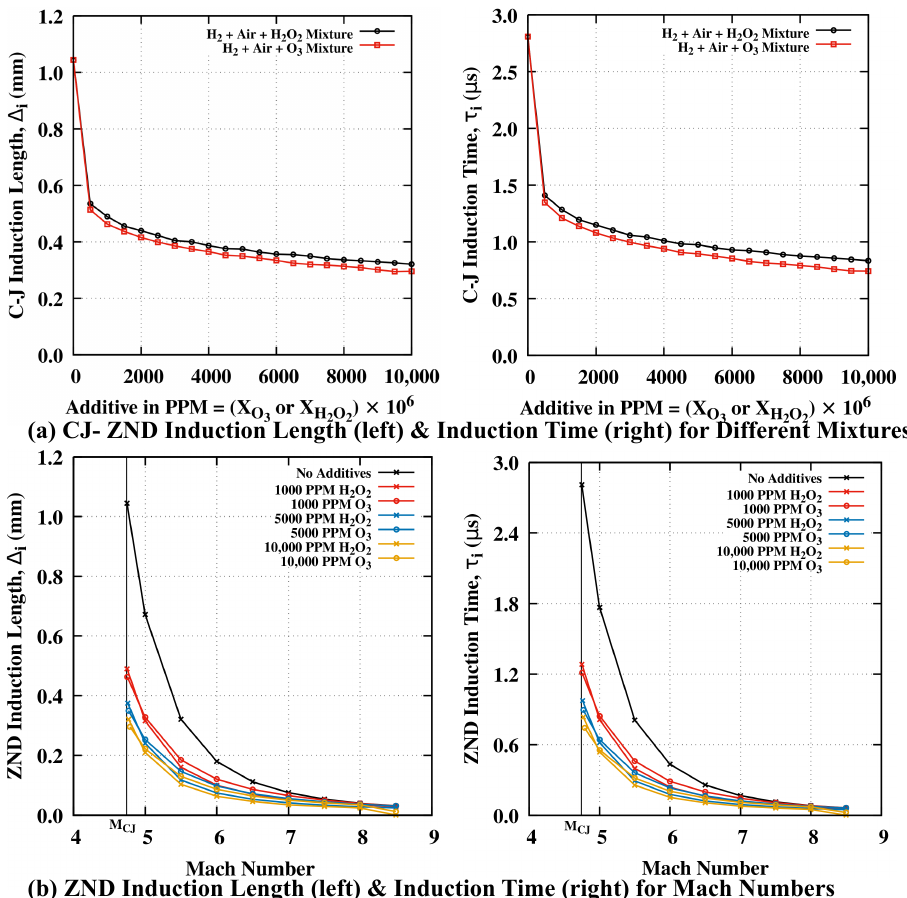
Figure 4. Induction Length ( ∆ i ) and Induction Time ( τ i ) variation with ( a ) Additives, based on CJ-ZND calculation ( b ) Mach number, based on overdriven ZND